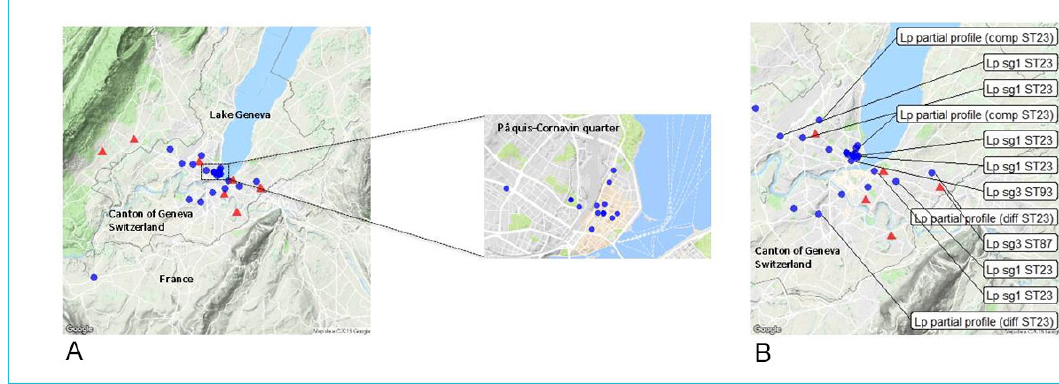
Figure 2: A: Mapping of confirmed cases of Legionnaires’ disease by place of residence, Geneva, Switzerland June-September 2017. Dots: patients linked to the highly affected Pâquis-Cornavin area. Triangles: patients having no link with the Pâquis-Cornavin area. To ensure better visibility, three cases are not represented in the zoomed-out map of Geneva. B: Mapping of the L. pneumophila (Lp) subtypes of 12 clinical samples. Dots: patients linked to the highly affected Pâquis-Cornavin area. Triangles: patients having no link with the Pâquis-Cornavin area. comp: compatible with; diff: different